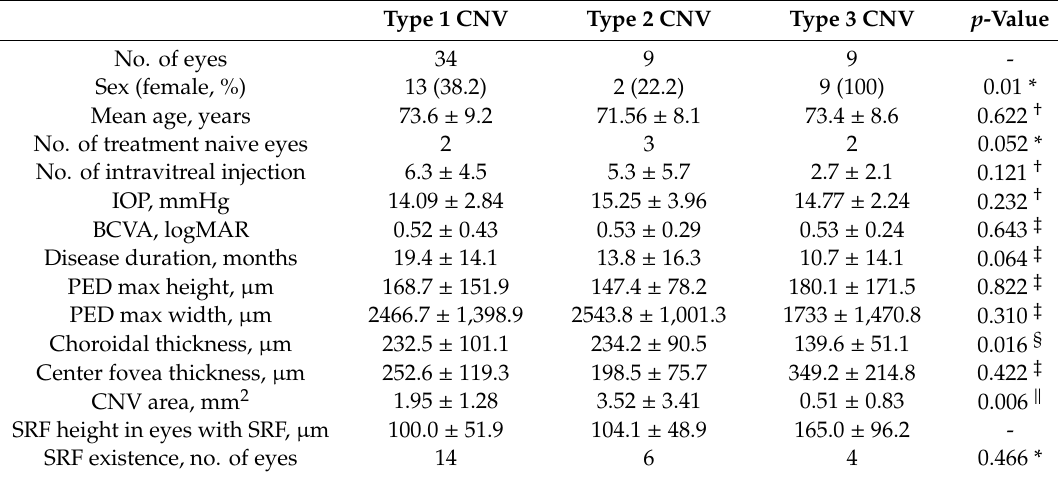
Table 3. Parameters of OCT in eyes with neovascular age-related macular degeneration according to subtype of choroidal neovascularization